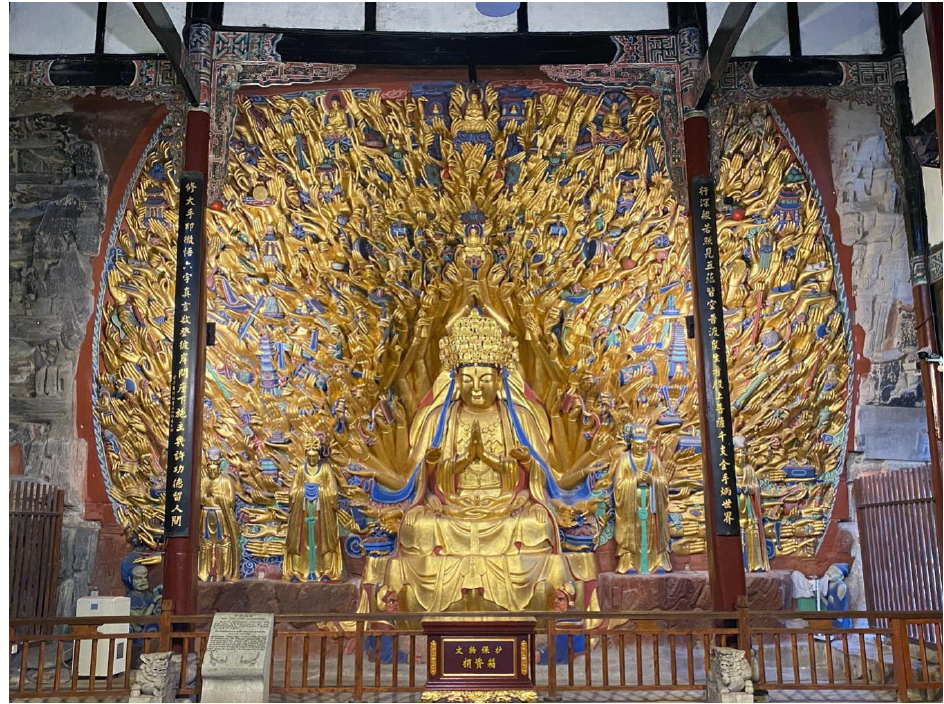
Figure 3. The Dazu Thousand-Hand Bodhisattva Statue located in Chongqing, China (2020)—photo by Su Yang.